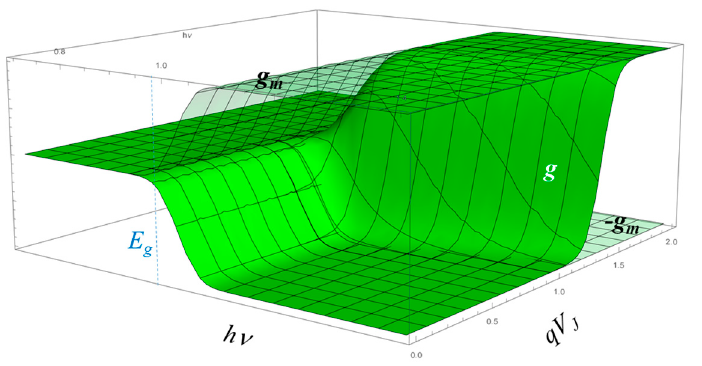
(cid:0) (cid:1) ( ) h ν , qV J Figure 7. Plot of the surface g from Equation (21) assuming a smoothed step function to qVhg , ν from Equation (21) assuming a smoothed step function to Figure 7. Plot of the surface J represent g m ( h ν ) ( ) ν hg represent . m